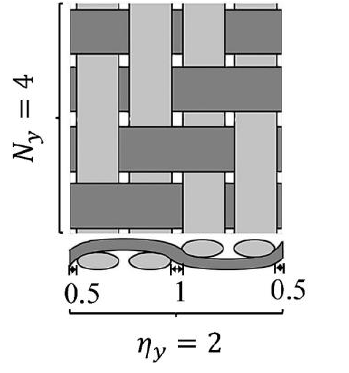
Figure 2. Illustration of inflection points.